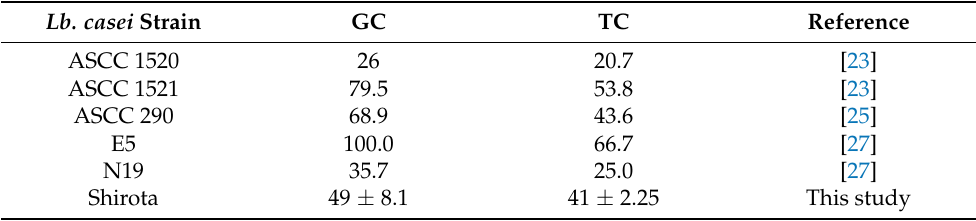
Table 4. Comparative values of the deconjugation percentage for sodium glycocholate and tauro- cholate in different strains of Lactobacillus casei